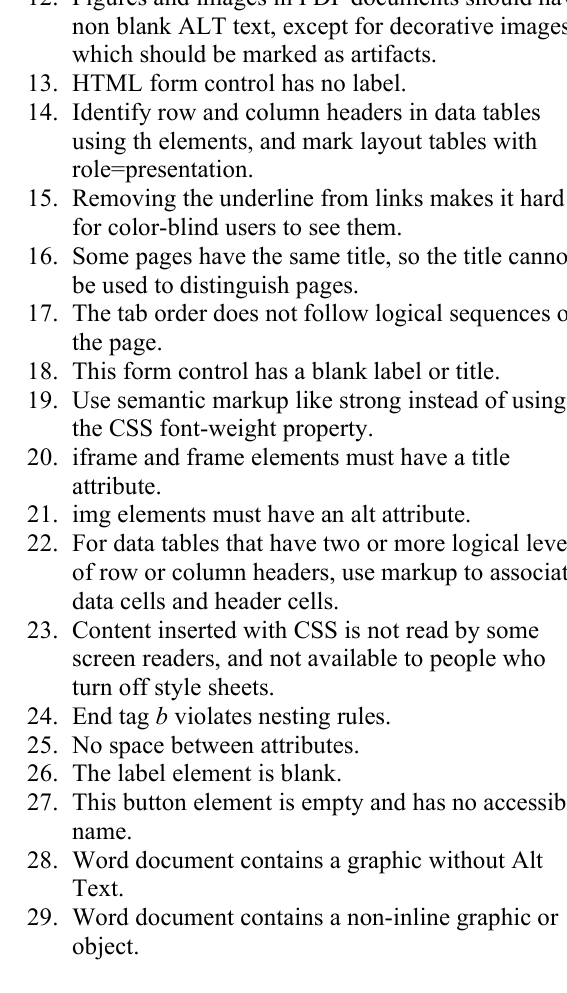
Table 1. Number of accessibility errors by section for